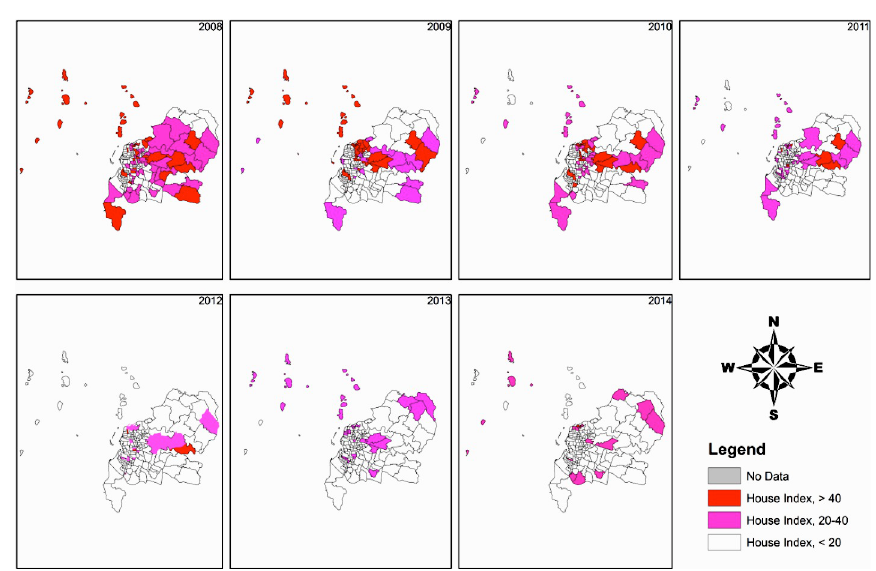
Fig 4. Reduction of Aedes Larval Densities—House Indexes (HI), in Makassar from 2008 to 2014. HI is indicated by color: Red = greater than 40%, Orange = 35% to 40%, Pink = 25% to 34% and white = 0% to 24%. (Map Source: ArcGIS